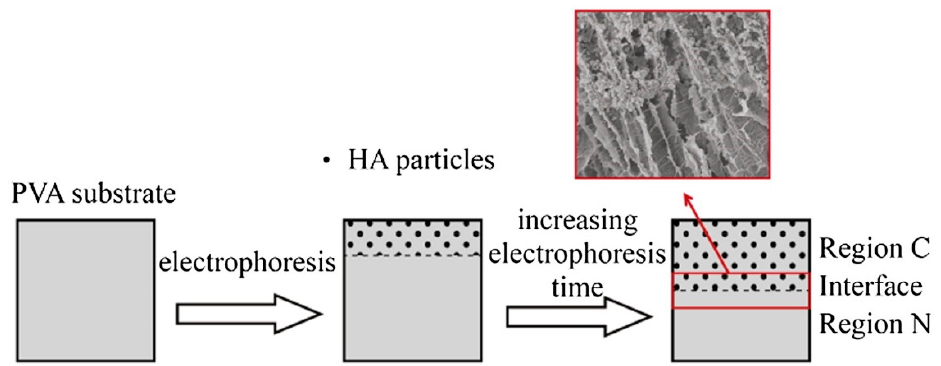
Figure 3. Illustration of the electrophoresis process. Insertion is the scanning electron microscope (SEM) image of the Interface. Reprinted from [11] with permission.